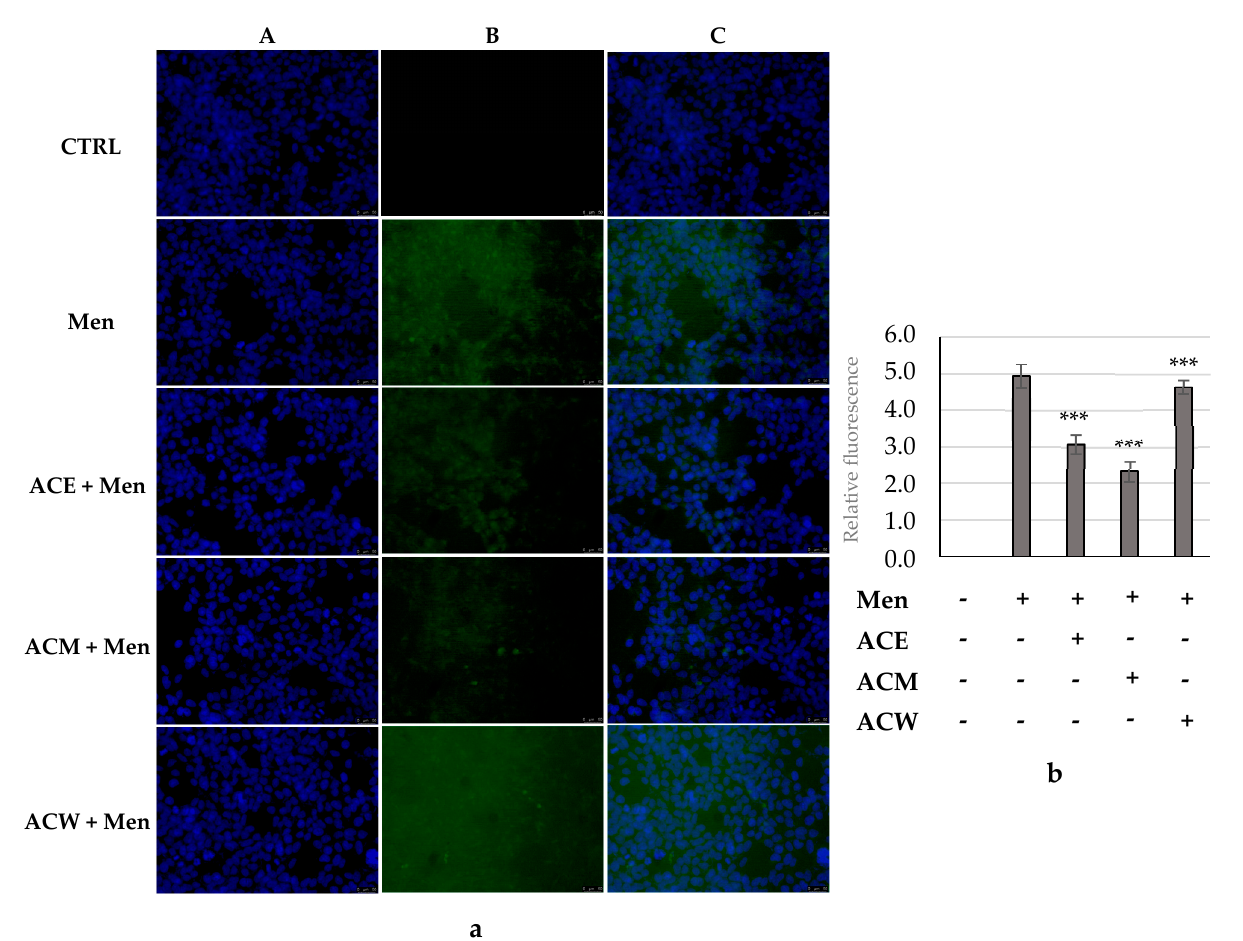
Figure 9. ROS scavenging activity. ( a ) Evaluation of ROS scavenging activity using DCF-DA (CF TM 488A) in Hek293 treated with Men (used as ROS inducer) or co-treated with Men and each A. cherimola Mill. leaf extract (ACE, ACM and ACW) at a concentration of 0.1 µ g/mL. Images were acquired at 20 × magnification. ACE and ACM pre-treatment reduce ROS production induced by Men of about 2- and 2.5-folds, whereas ACW demonstrated a lower but significant ROS scavenger activity. ( A ) DAPI ( λ ex/em = 350/460 nm); ( B ) CF TM 488A ( λ ex/em = 490/515 nm); ( C ) overlay channel. ( b ) Fluorescence quantification; *** p < 0.001, Men+ACE, Men + ACM and Men + ACW vs.